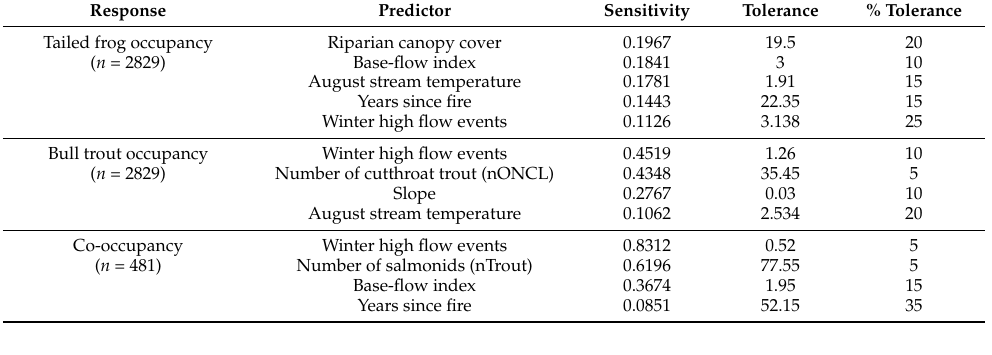
Table 3. Important predictors of tailed frog occupancy, bull trout occupancy, and co-occupancy. For each predictor variable, we show its Sensitivity (relative importance), Tolerance (niche breadth), and % Tolerance (percent of the variable’s range) values for each model.